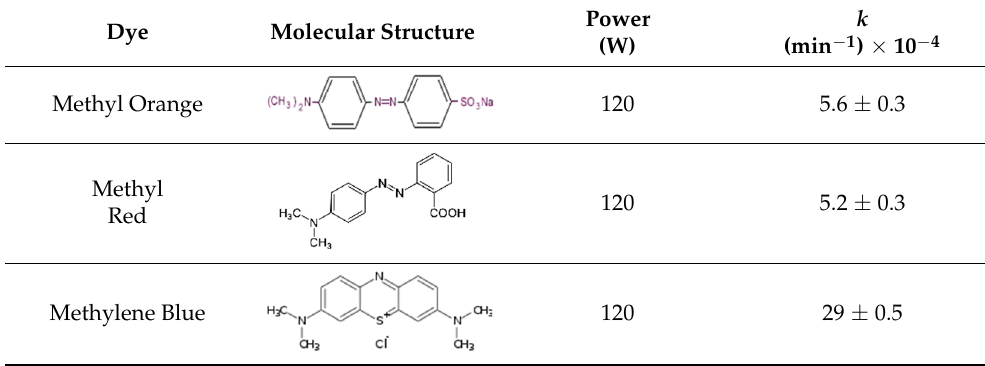
Table 3. (A) Apparent rate constants for the UV/TiO 2 photo-catalysis at 120 W (tests no. 18) for Methyl Orange, Methyl Red, and Methylene Blue, [dye] = 0.7 mg/L; TiO 2 = 0.79 g/cm 3 ; distilled water (pH = 6); Q = 0.305 L/s; hw = 13.5.